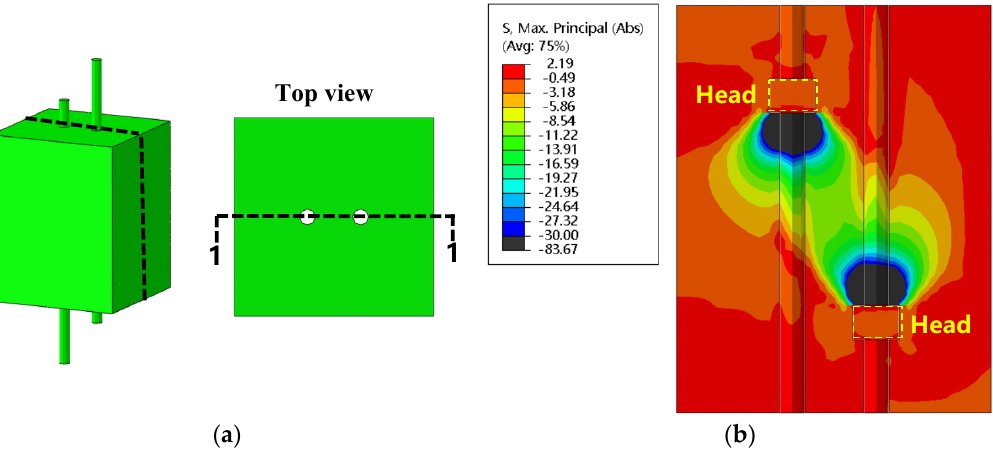
Figure 32. Concrete stress contour ( a ) Section of the specimen; ( b ) Maximum principal stress contour at 1-1 section.